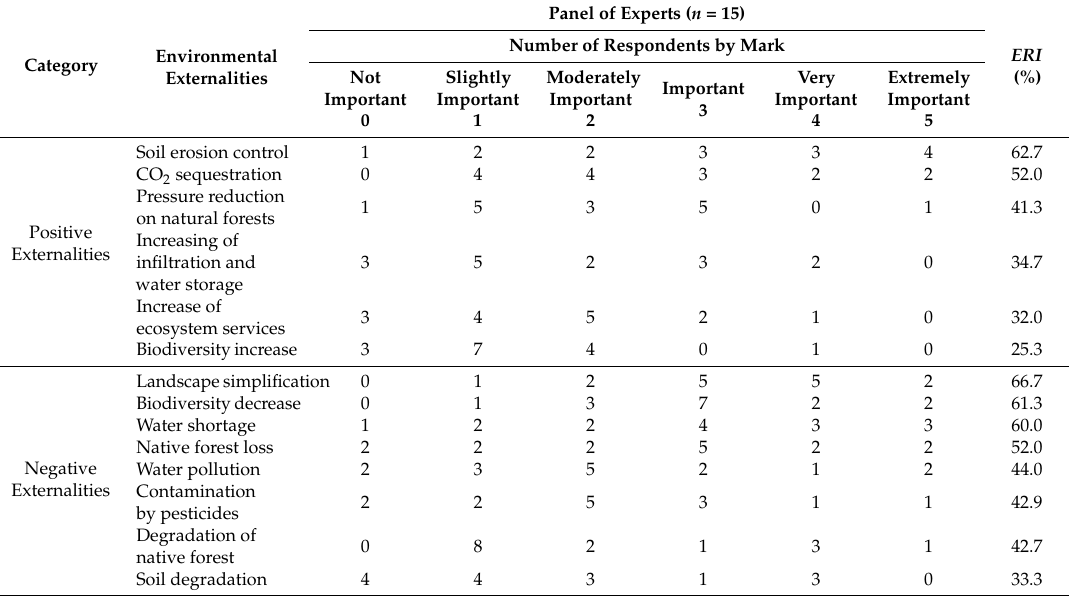
Table A2. Frequency of the Likert scale per externality and relative scores of environmental externalities according to the experts’ consultation.